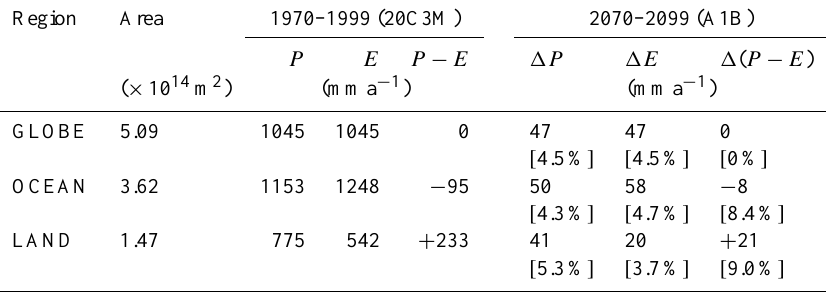
Table 1. Mean annual water balance over the globe, ocean and land simulated at the end of the 20th century (1970–1999, 20C3M) and the changes projected to the end of the 21st century (2070–2099, A1B). The percentages are shown below the projected changes. Note that the change in global mean surface temperature between the two periods is + 2.8K, giving a projected change in global P (and E ) of (4.5%/2.8K=)1.6%K − 1